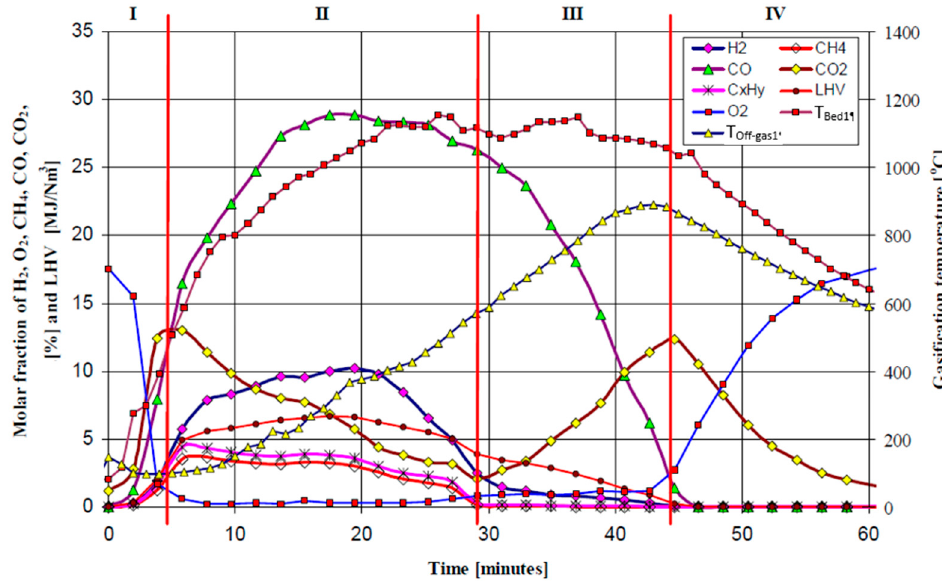
Figure 9. Changes of the fuel gas composition (H 2 , CO, CO 2 , CH 4 , C x H y , O 2 ), LHV, gasifier bed temperature (T b1 ) and the exiting fuel gas temperature (T og1 ), versus gasification process time. Feed conditions: 50 Nm 3 / h of air preheated up to 350 ◦ C (gasification 20 kg of 12 mm wood pellets).